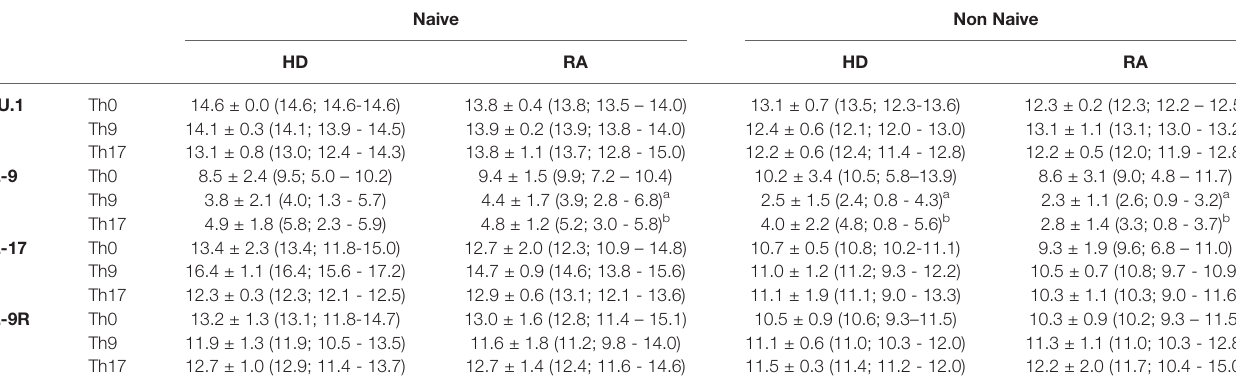
TABLE 3 | Relative mRNA expression of PU.1, IL-9, IL-17 and IL-9R in control conditions (Th0), Th9- and Th17-inducing conditions in naive and non-naive T cells of healthy donors (HD) and rheumatoid arthritis (RA) patients. Naive Non Naive